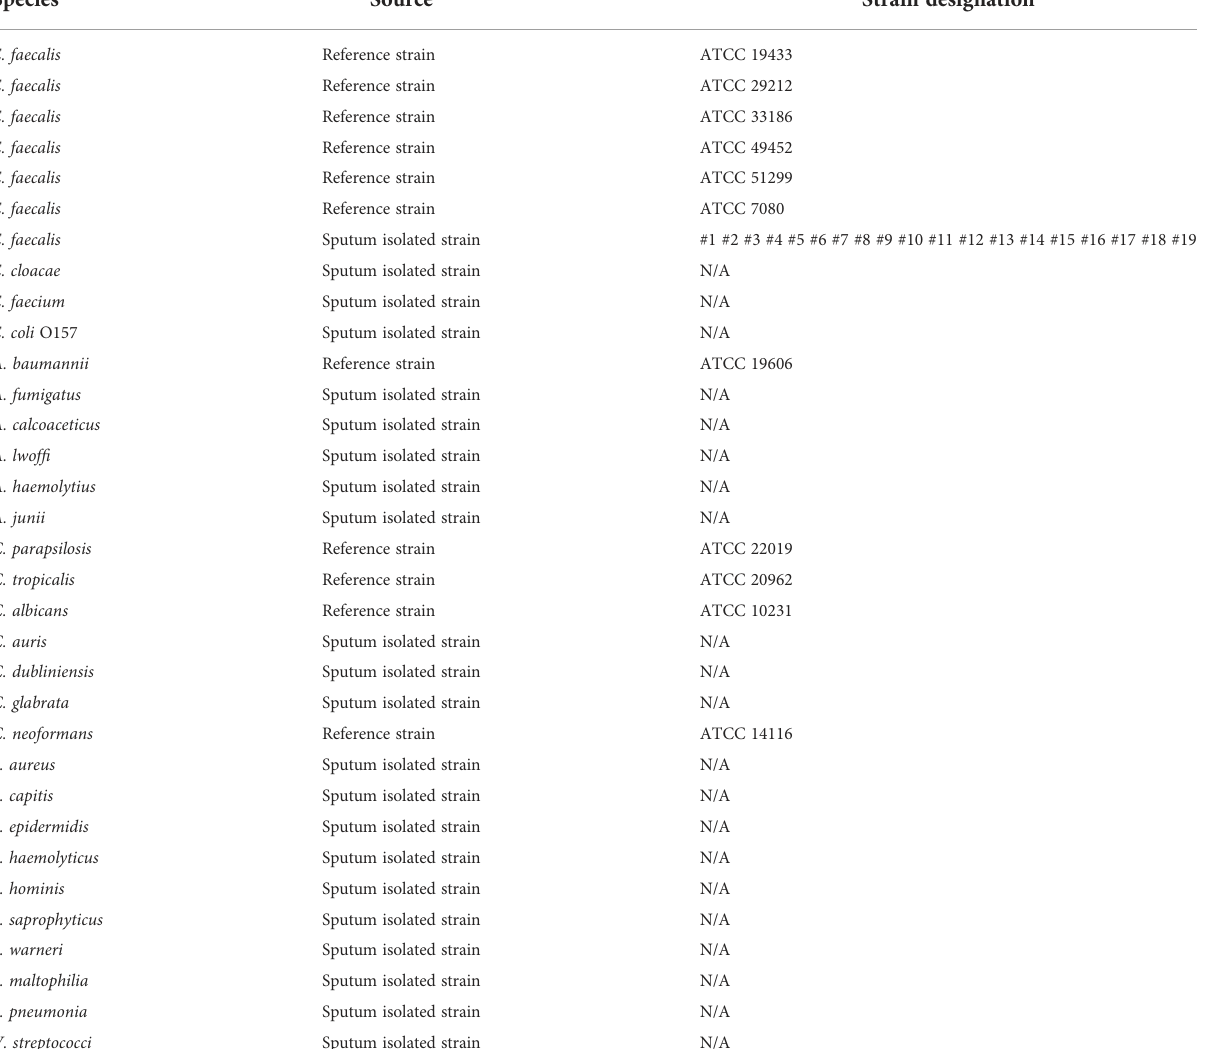
TABLE 1 The bacterial strains used in this study.